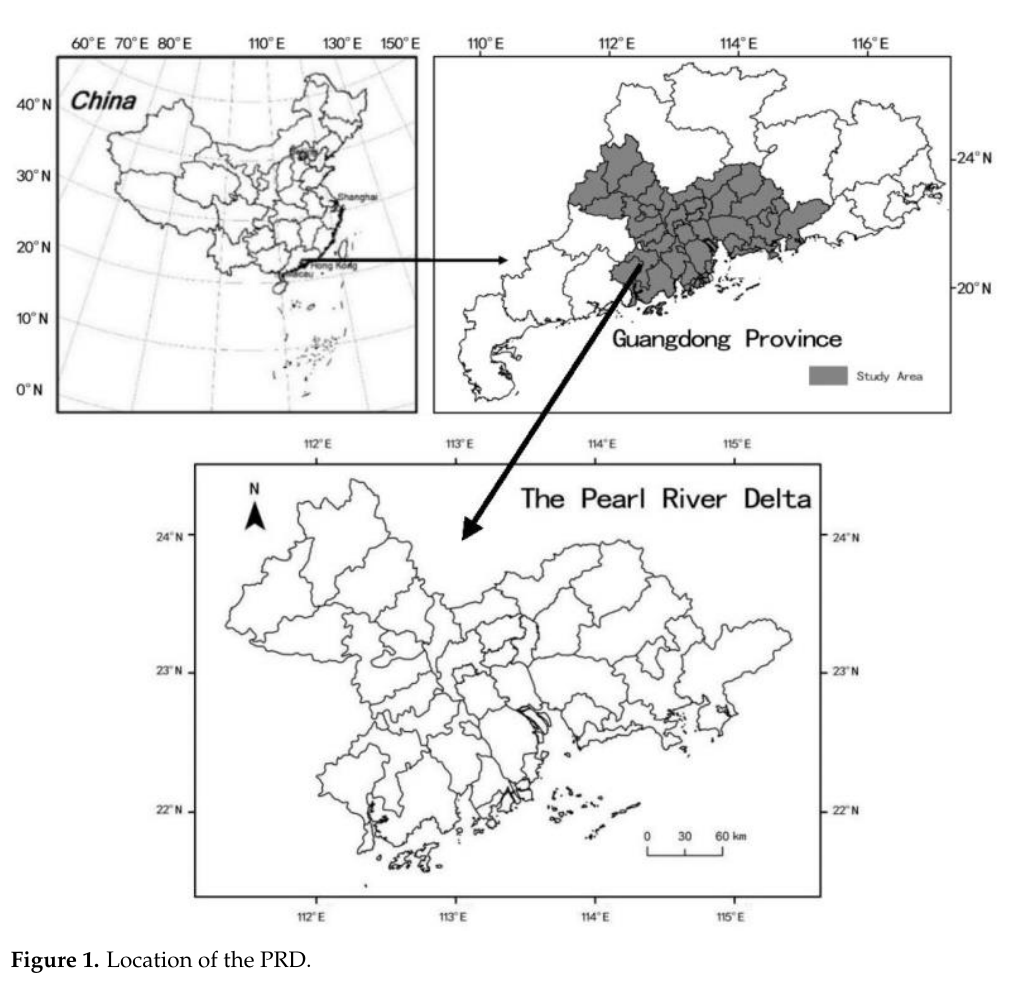
Table 1. The economic profile of secondary industries in the PRD from 1990 to 2020.